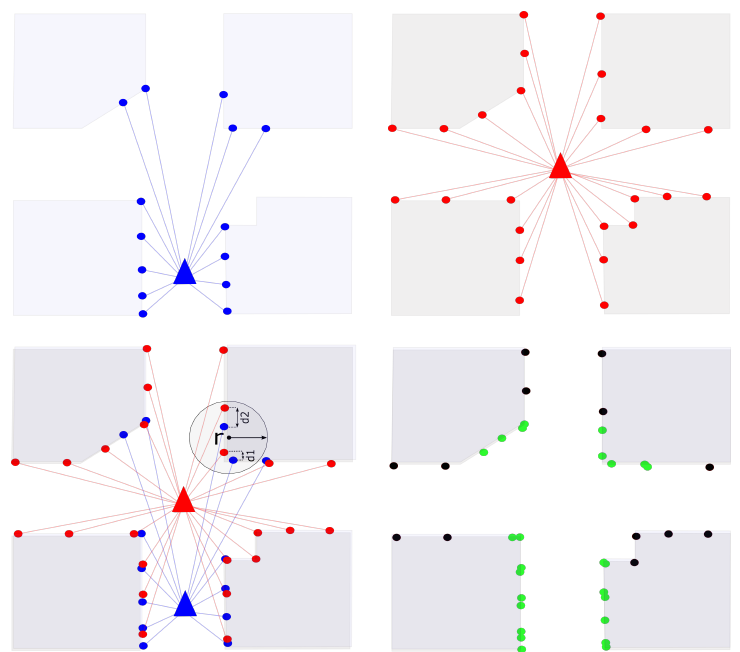
Figure 3. Scan registration sequence, upper left and right illustrations are showing two successive scans, the left lower figure is showing the overlapping area with the error estimation in certain radius r , the right lower figure shows a registered scan where green points representing the overlapping points and the black point are the new added point from the second scan (red).